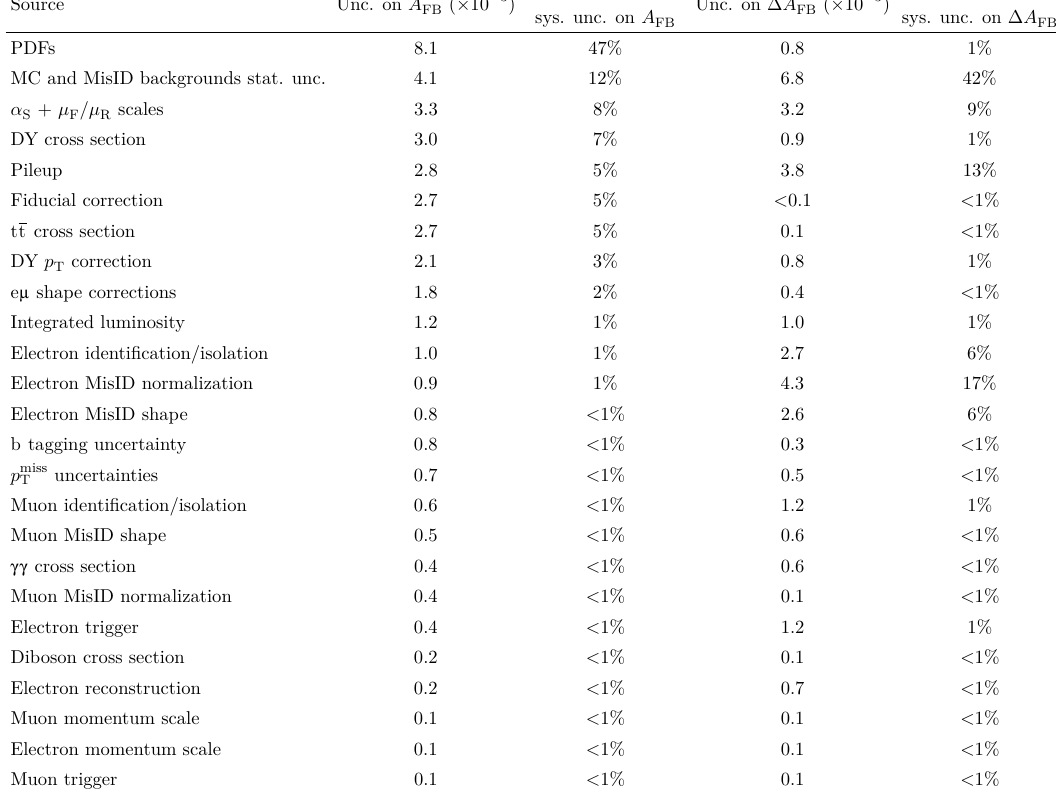
Table 1 . A comparison of the magnitude of the different sources of systematic uncertainty for the measurement of A when combining the muon and electron channels and for the measurement of FB ∆ A . Results for the 170–200 GeV mass bin are shown because that is the mass bin in which the FB systematic uncertainty has the largest contribution to the total uncertainty; the results for other mass bins are similar. Results are also reported as a fraction of the overall systematic uncertainty for the measurement of A and ∆ A . Sources are listed in order of the size of their contribution FB FB to the uncertainty in A FB